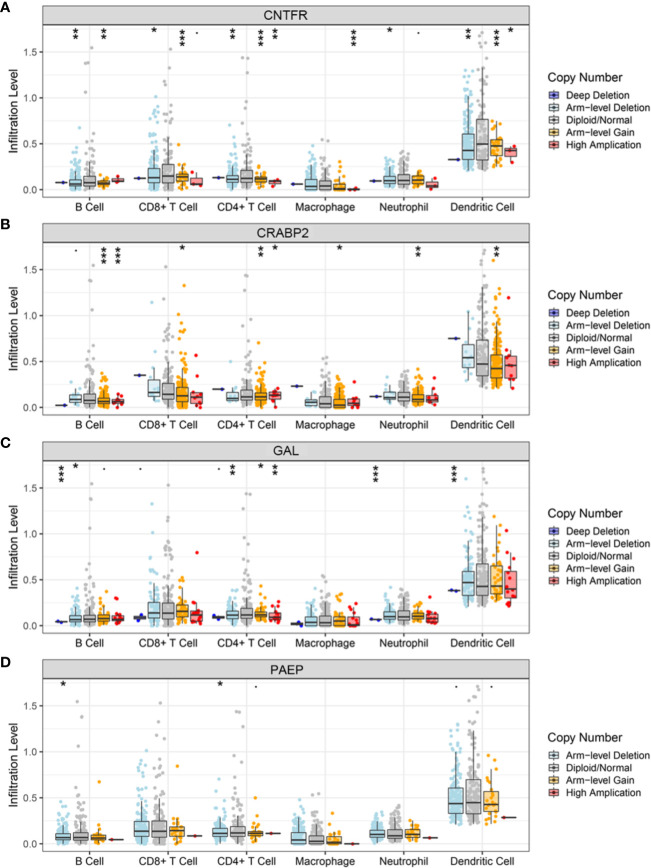
Relationships of the CNVs of four hub TMB-related genes with immune cells infiltration. (A–D) Immune infiltration levels of CD8+ T cell, CD4+ T Cell, neutrophil cell, dendritic cell, macrophage, and B cell were commonly decreased in diverse forms of CNVs compared with copy number normal of CNTFR, CPABP2, GAL, and PAEP. CNVs, copy number variations; TMB, tumor mutation burden; CNTFR, ciliary neurotrophic factor receptor; CRABP2, cellular retinoic acid binding protein 2; GAL, galanin and GMAP prepropeptide; PAEP, progestogen-associated endometrial protein. *, <0.05; **, <0.01; ***, <0.001.